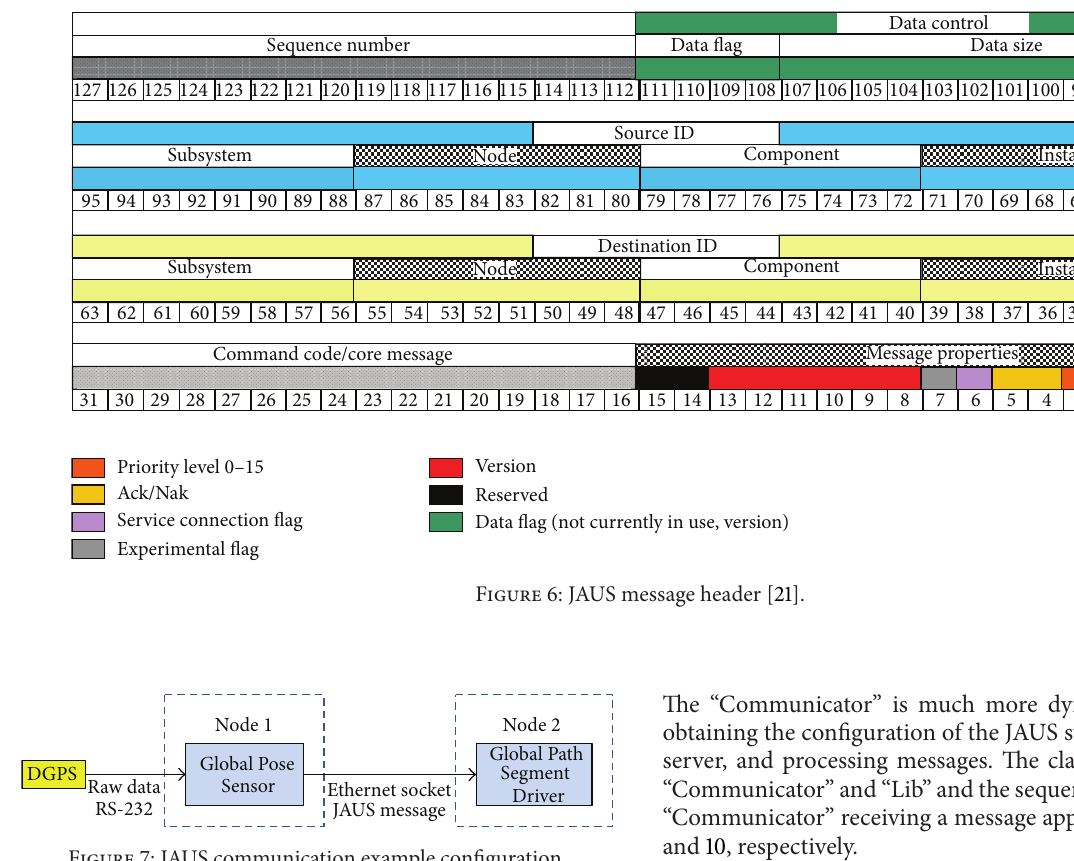
Figure 7: JAUS communication example